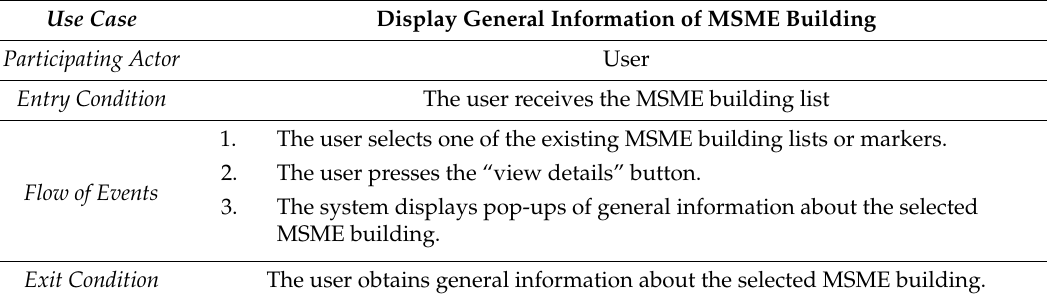
Figure 7. Building data digitalization. Table 1. Displaying general information about the micro, small, and medium enterprise (MSME) building scenario.